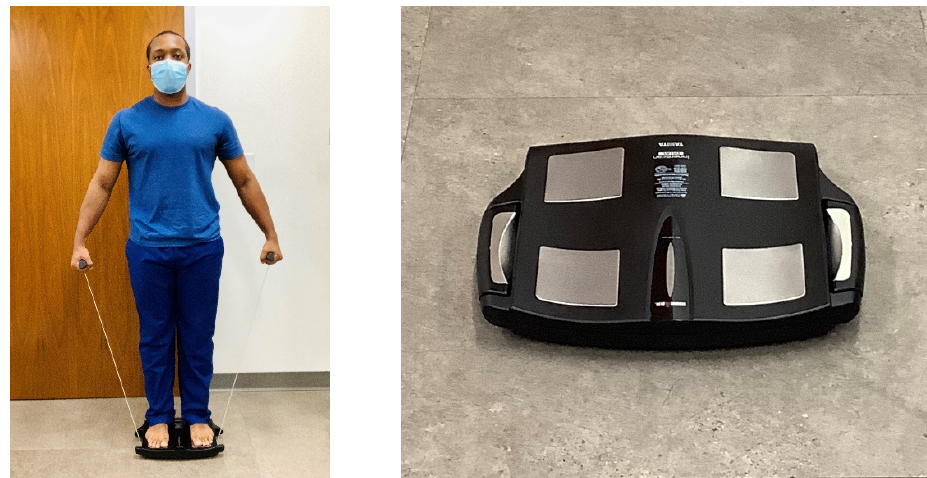
Figure 3. Home-based bioimpedance device; photo courtesy of Clifton J. Holmes, PhD.